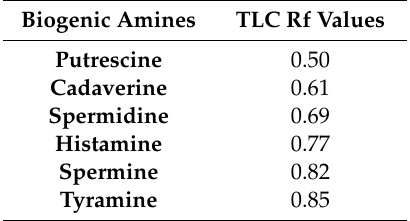
Table 1. Rf values of the different biogenic amine-dansyl derivatives separated by the TLC method.